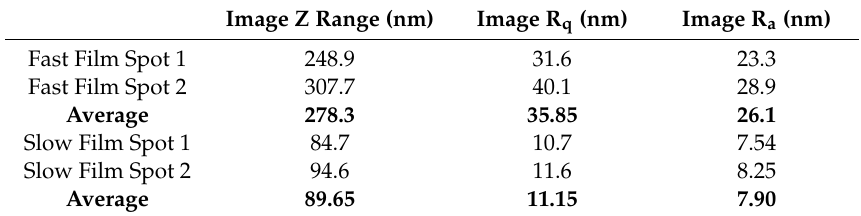
Figure 4. AFM images for fast ( top row ) and slow ( bottom row ) filtered films formed from 400 µL aliquots of arc-discharge SWCNT suspension. Table 1. Quantitative atomic force microscopy (AFM) roughness data for fast and slow-filtered films formed from 400 µ L aliquots of arc-discharge SWCNT